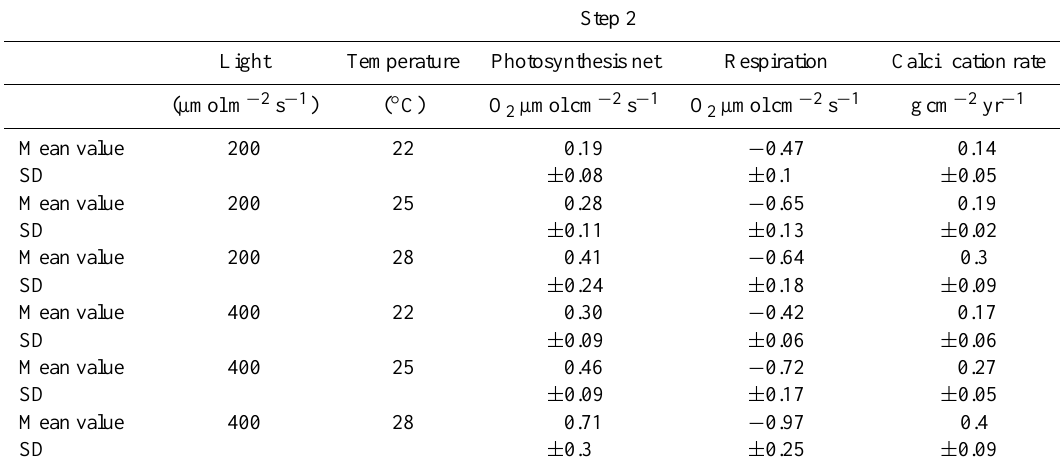
Table 3. Mean value and standard deviation of photosynthesis (Pnet, O 2 µmolcm − 2 s − 1 ) , respiration ( R , O 2 µmolcm − 2 s − 1 ) , and